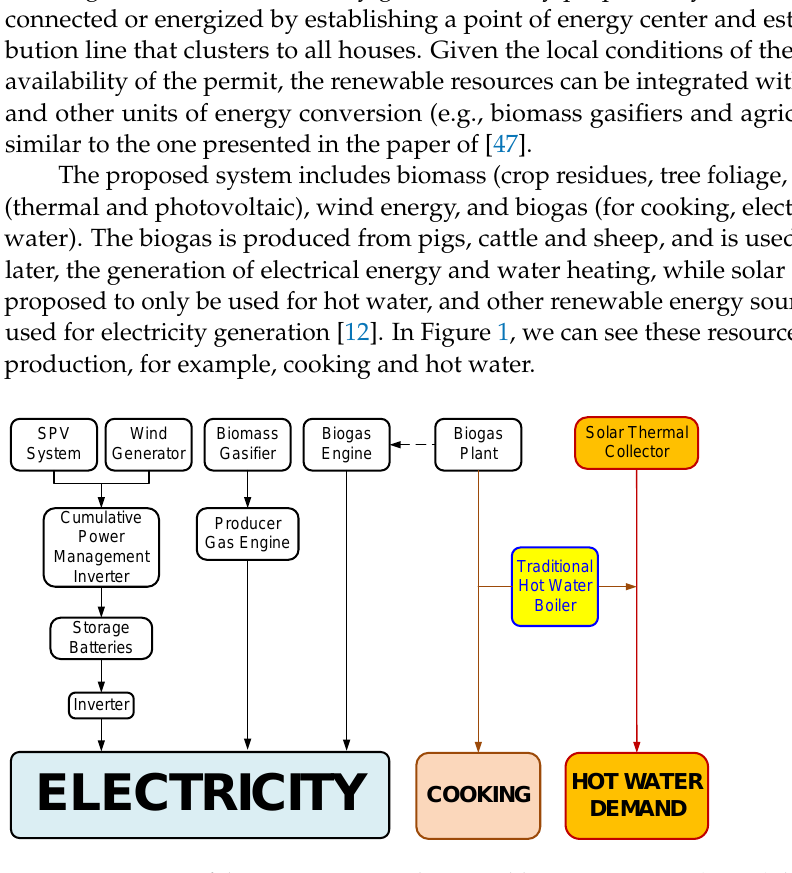
Figure 1. Diagram of the Smart Integrated Renewable Energy System (SIRES), based on